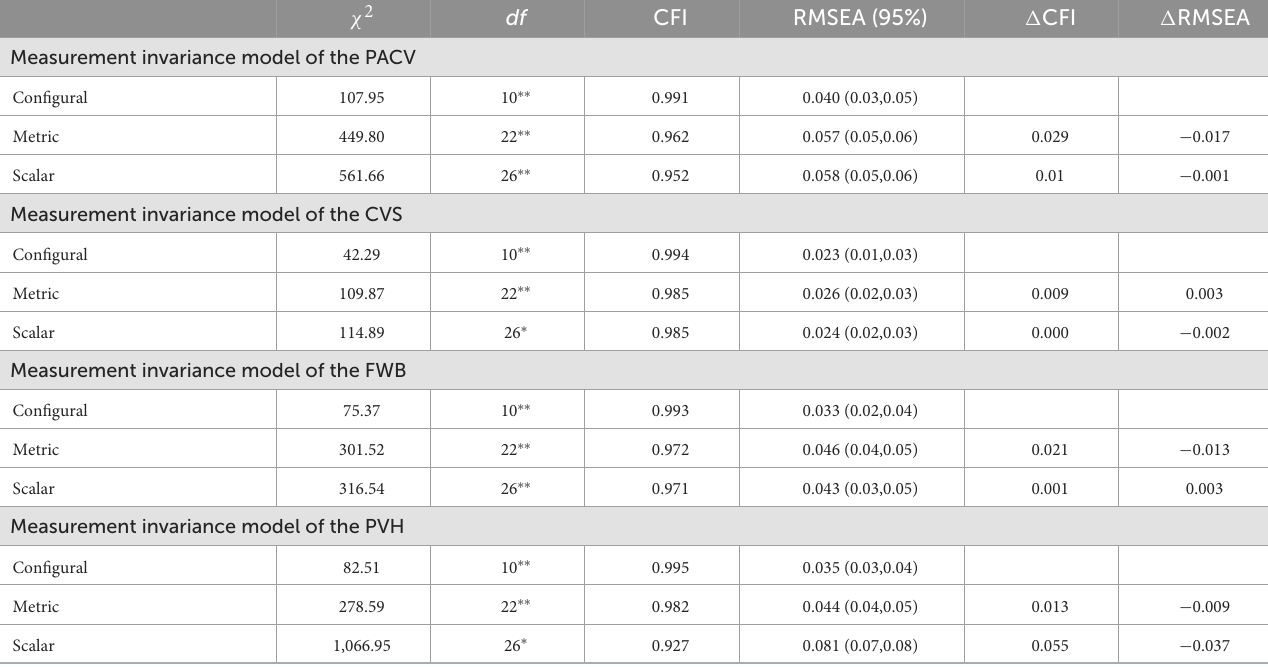
TABLE 5 Model fit statistics for the multi-group confirmatory factor